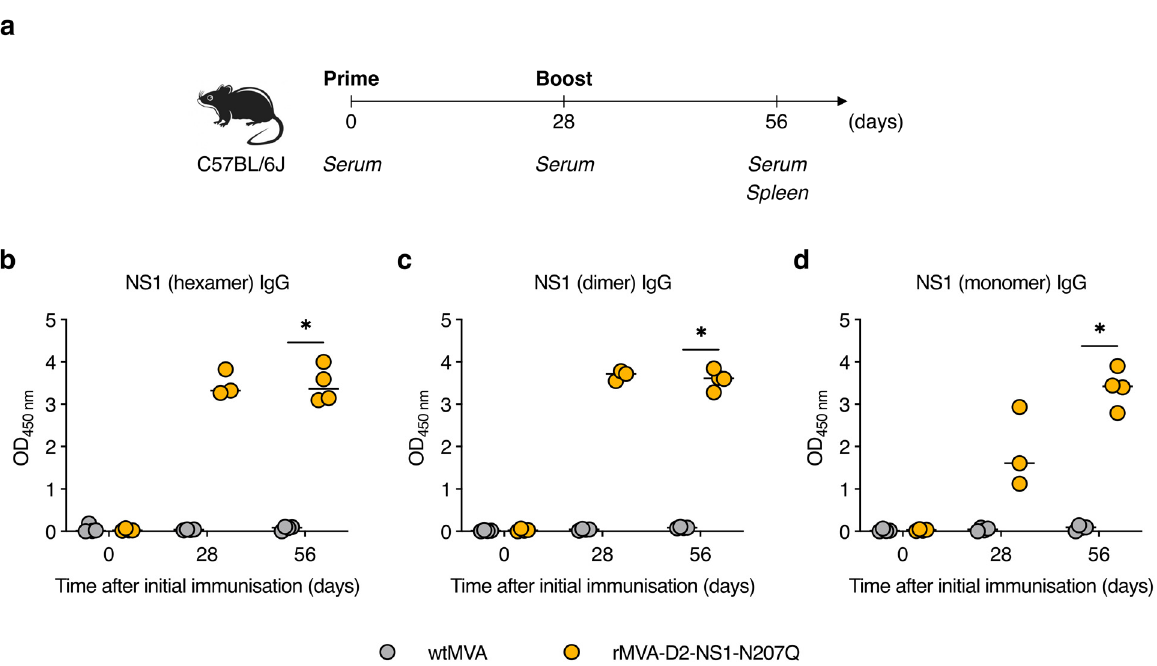
Figure 3. rMVA-D2-NS1-N207Q induces robust NS1-specific antibody responses in mice. ( a ) Experi- mental protocol. C57BL/6J mice were immunised intramuscularly with 10 7 PFU of wtMVA ( n = 4) or rMVA-D2-NS1-N207Q ( n = 4) on days 0 and 28. ( b – d ) Sera collected on days 0, 28, and 56 were diluted 100-fold and tested for NS1-specific IgG antibodies by ELISA using plates coated with NS1 hexamers ( b ), NS1 dimers ( c ), or NS1 monomers ( d ). Note that sera of only three mice from the rMVA-D2-NS1-N207Q group were obtained on day 28. Each data point represents one mouse and short horizontal lines represent medians. *, p < 0.05 (Mann–Whitney U test).